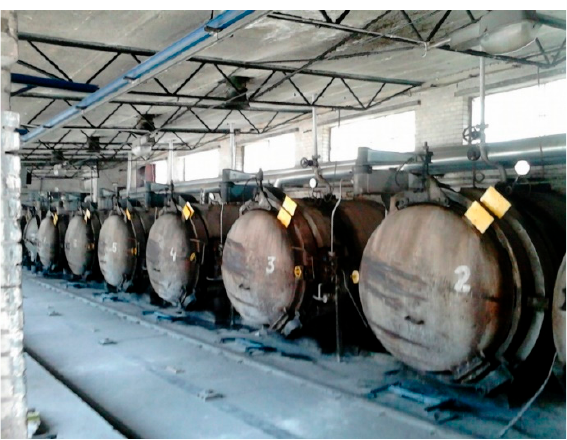
Figure 7. View of the production hall with autoclaves.